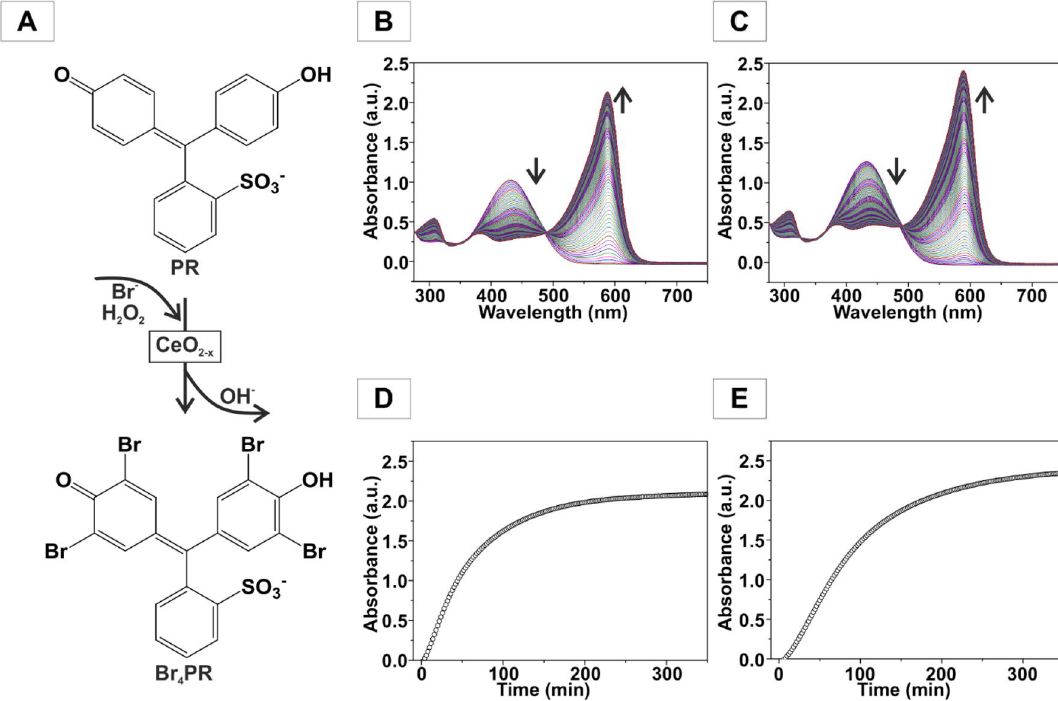
Figure 4. Scheme of the ( A ) oxidative bromination of PR. Spectral changes induced by the oxidative bromination of PR with time for the determination of the haloperoxidase activity of CeO 2 obtained ( B ) from batch chemistry and ( C ) under segmented flow conditions after annealing at 185 °C, ( D ) the corresponding absorbance change at 590 nm as a function of time ( E ) the corresponding absorbance change. Assay